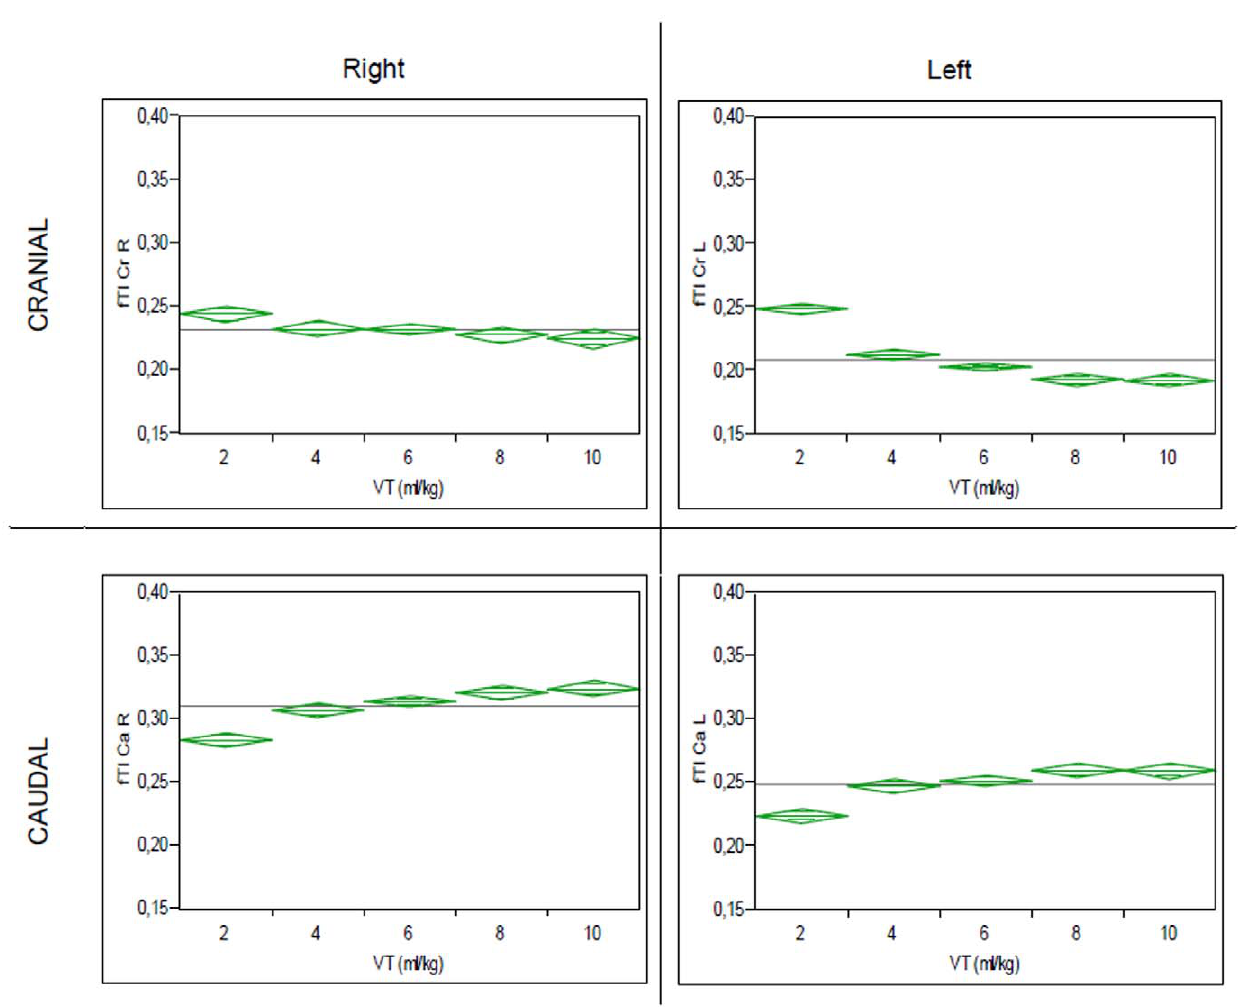
Figure 7. Distribution of fTI in different quadrants at different VT, post-lavage. Shown are mean (grey line) fTI values for different VT, with 95%-Confidence Interval of the mean (green diamonds).